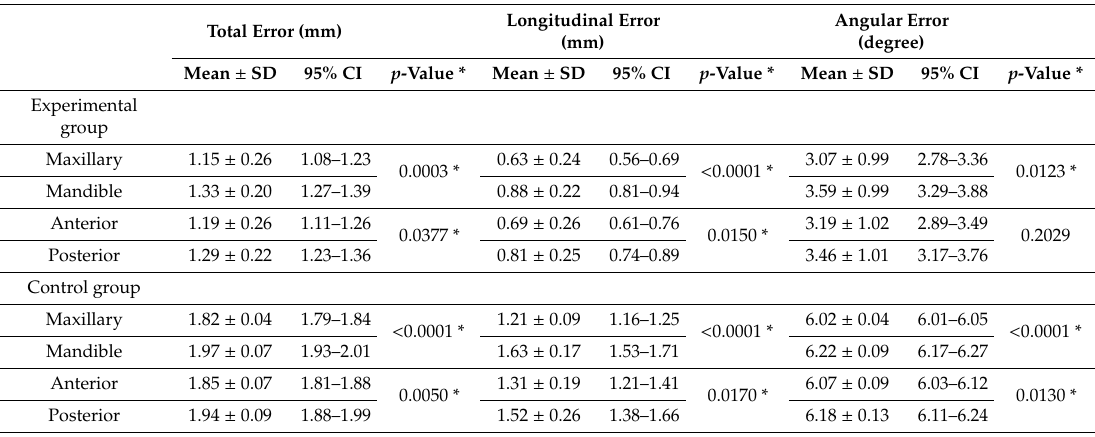
Table 2. The deviation of the total, longitudinal, and angular errors in experimental and control groups by di ff erent jaw and dental